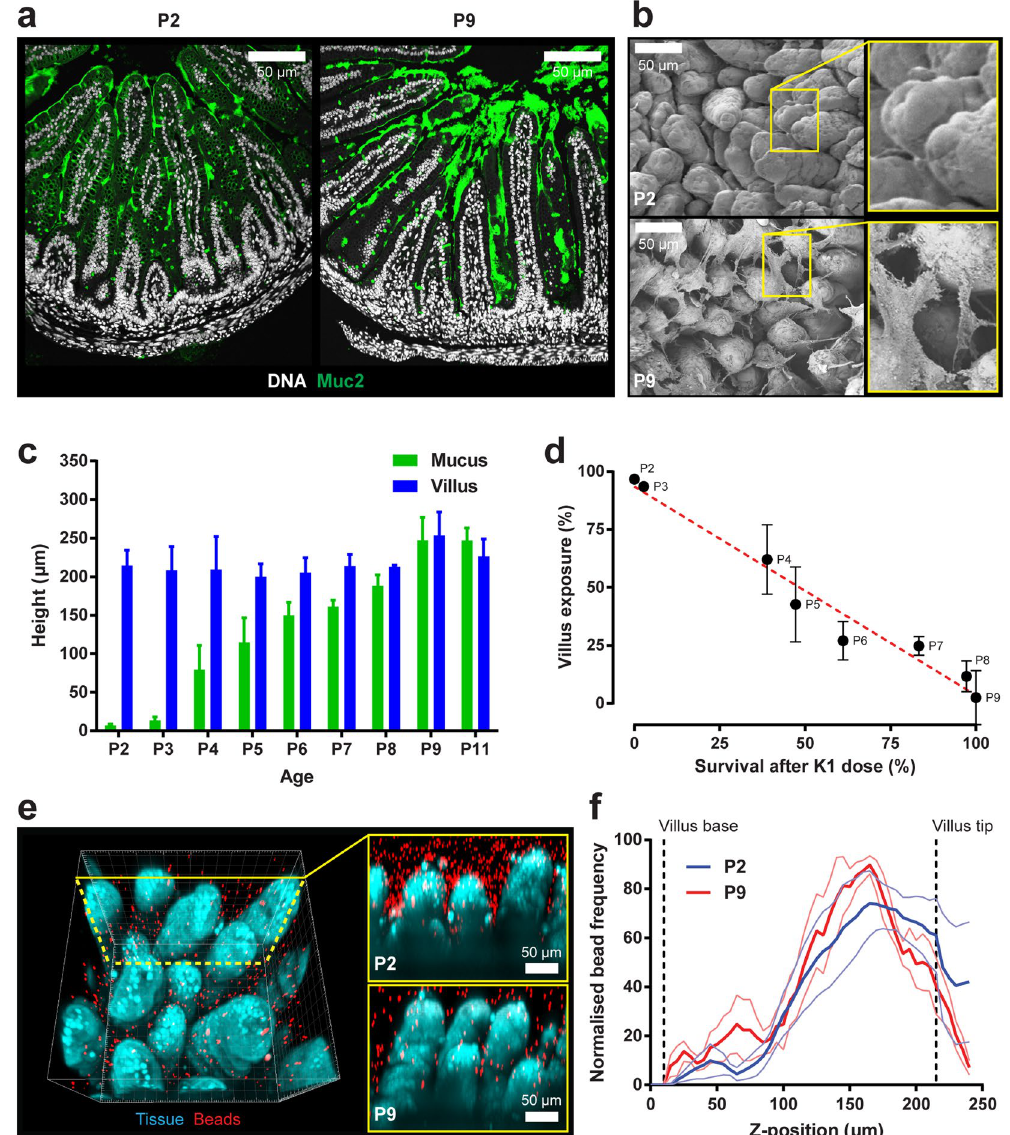
Figure 6. Postnatal MSI mucus layer maturation correlates with increased resistance to E. coli K1 systemic infection. ( a ) Confocal micrographs of Methacarn-fixed MSI tissue sections from neonates at P2 and P9; sections stained for Muc2 (green) and DNA (grey). ( b ) SEM of neonatal MSI tissue obtained at P2 and P9; right panels show magnification of inset yellow boxes in left panels. ( c ) Ex-vivo quantification of MSI mucus layer and villus height from P2-P11; n = 4 animals, mean ± SEM. ( d ) Correlation between MSI villus exposure (proportion of villus not covered by mucus layer) and survival between P2-P9 after initiation of E. coli A192PP colonization at P2; n = 4 animals, mean ± SEM, linear regression of data indicated by red dashed line. ( e ) Confocal z-plane projection of fluorescently labelled ex-vivo MSI tissue overlaid with fluorescent beads; representative 3D projection (left panel) and x/z-axis cross-sections from P2 and P9 tissues (right panels; yellow box) shown; labelled tissue (blue), fluorescent beads (red). ( f ) Quantification of z-axis bead distribution in mucus of MSI tissue from P2 and P9 neonates; data from confocal z-plane projections as shown in ( e ); error bars are SEM from n = 4 animals, mean ± SEM (thin lines); approximate positions of the villus base and tip along the z-axis are indicated (dashed